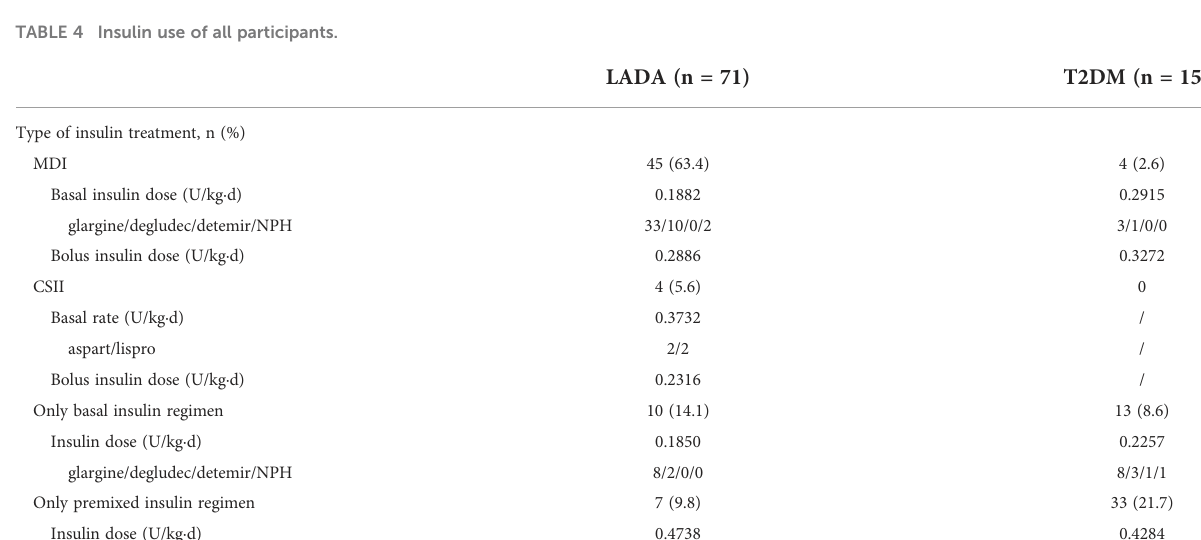
TABLE 4 Insulin use of all